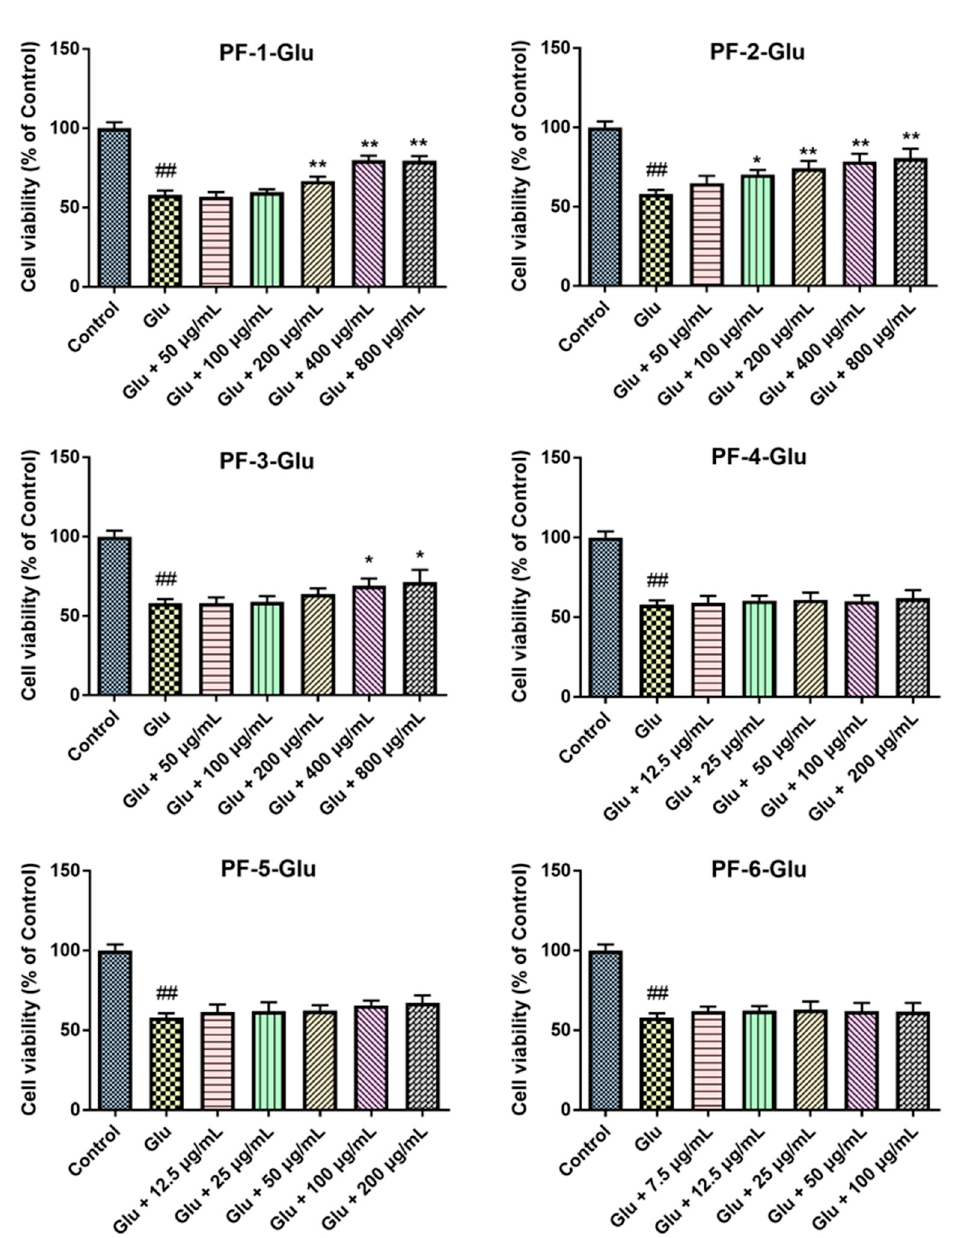
Figure 3. Effects of PF-1 to PF-6 on the cell viability of Glu-stimulated PC12 cells. Cells were treated with different fractions at corresponding concentrations for 24 h, and then Glu (the final concentration of 20 mM) was added for 24 h. The cell viability was determined by MTT. ## p < 0.01 vs. the control group, * p < 0.05 vs. the Glu-treated group, ** p < 0.01 vs. the Glu-treated group.